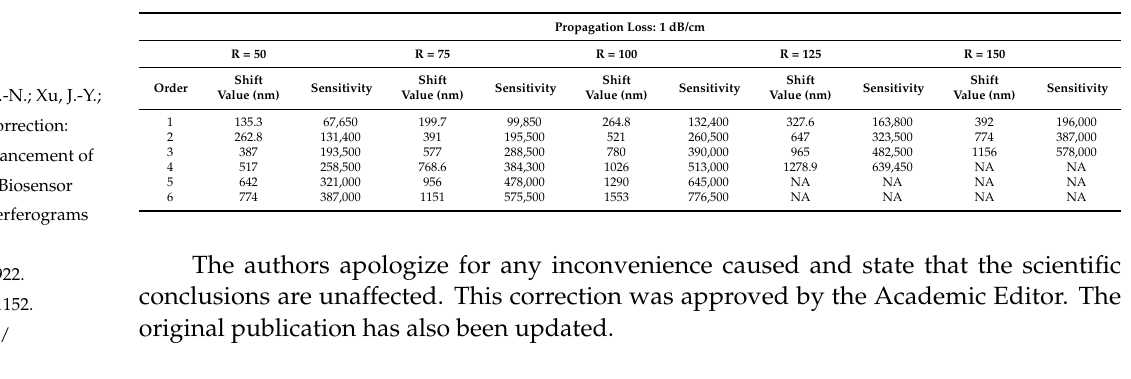
Table 3. The order shift distance and sensitivity for five different MRR radii under two cladding-layer refractive indices—1.31 and 1.312 for 1 dB/cm propagation